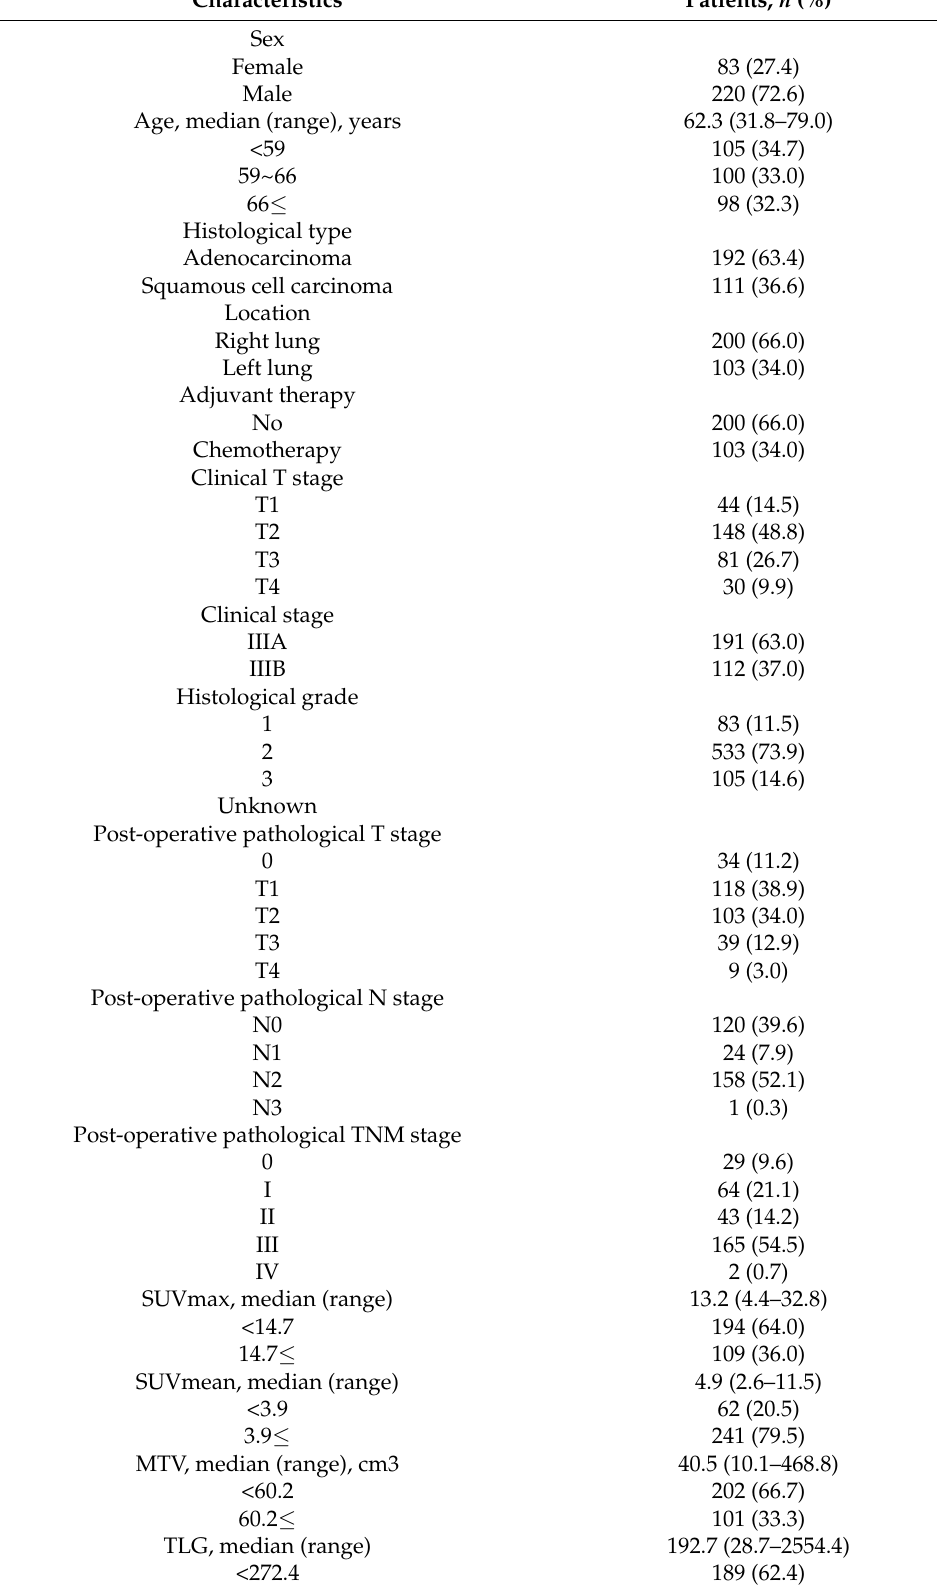
Table 1. Demographic and clinical characteristics of patients with lung